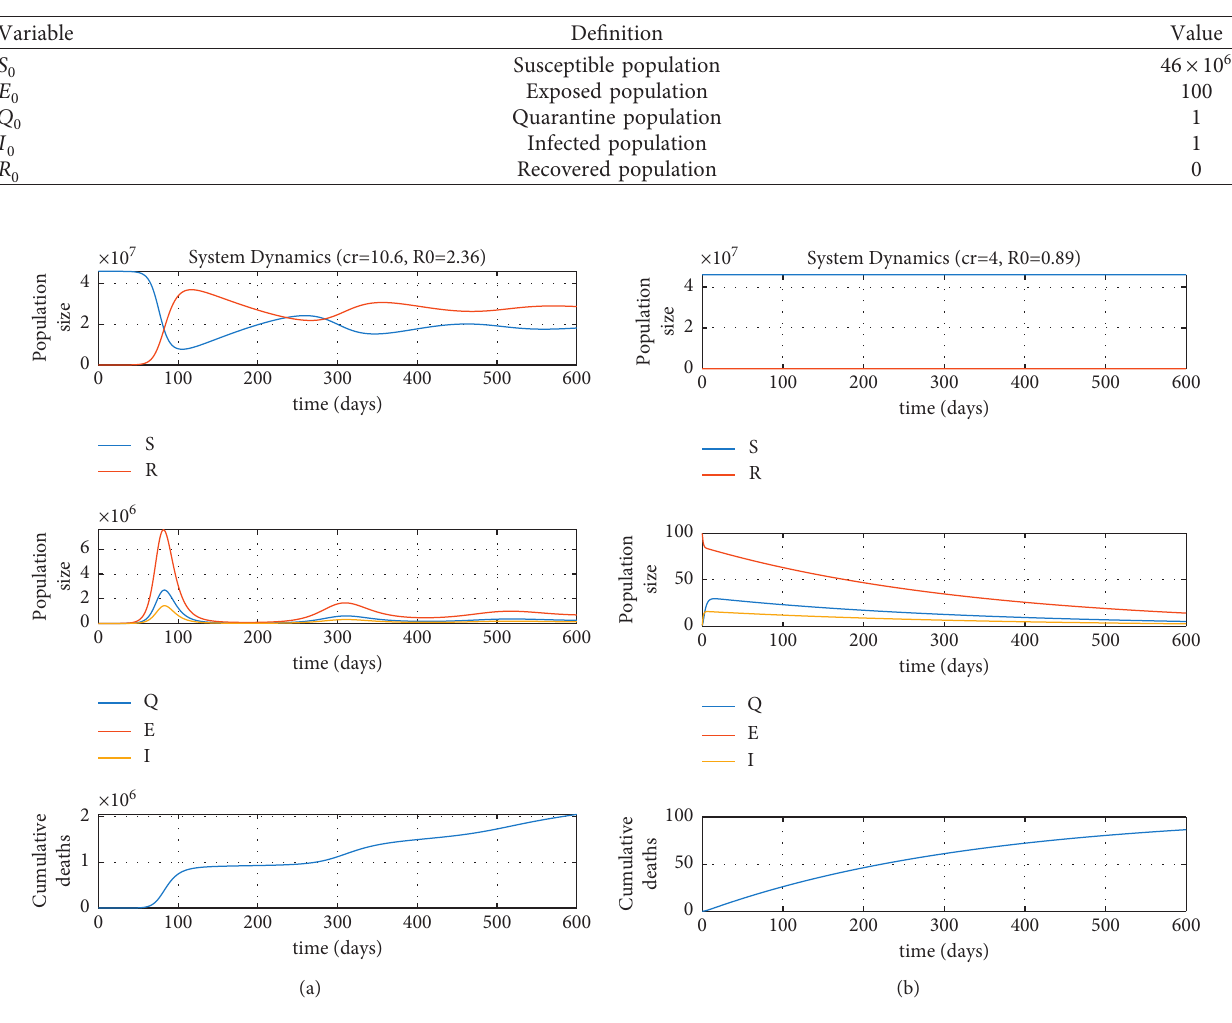
� 4 and R � 0.89 r 0